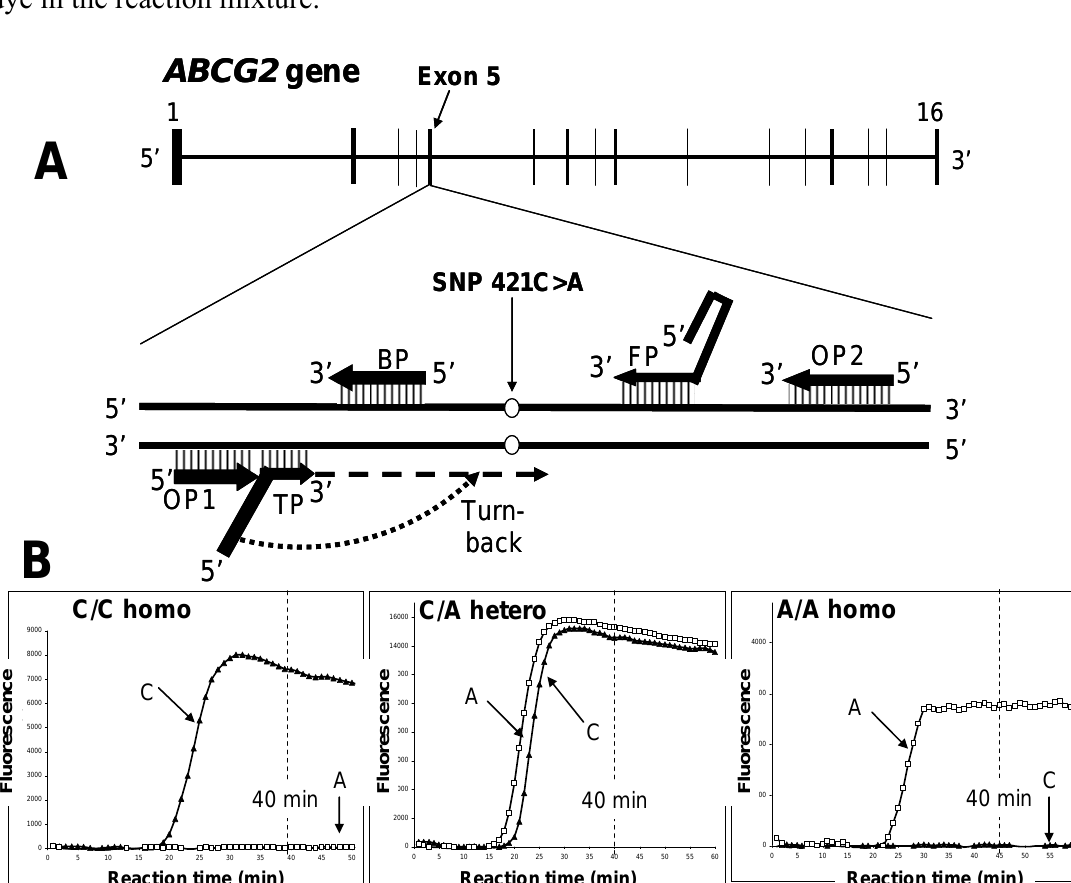
Figure 7. Rapid genetic testing to assess gout risk by the SmartAmp method. ( A ) Schematic illustration of the human ABCG2 gene located on chromosome 4q22. The SNP 421C>A resides in exon 5. ( B ) Detection of SNP 421C>A in the human ABCG2 gene by the SmartAmp method. Three panels depict the time-courses of the SmartAmp assay reactions with ABCG2 allele–specific primers carrying WT (421C) or SNP (421A) alleles; namely, C/C homozygote, C/A heterozygote, and A/A homozygote. After genomic DNA in peripheral blood samples (5 μ L) was denatured at 98 °C for 3 min, the genotyping reactions were allowed to proceed isothermally at 60 °C for 60 min in a Mx3000P PCR system (Agilent Technologies, Santa Clara, CA, USA) [48]. DNP amplification was continuously monitored by detecting the fluorescence of DNA-intercalated SYBR Green I dye in the reaction